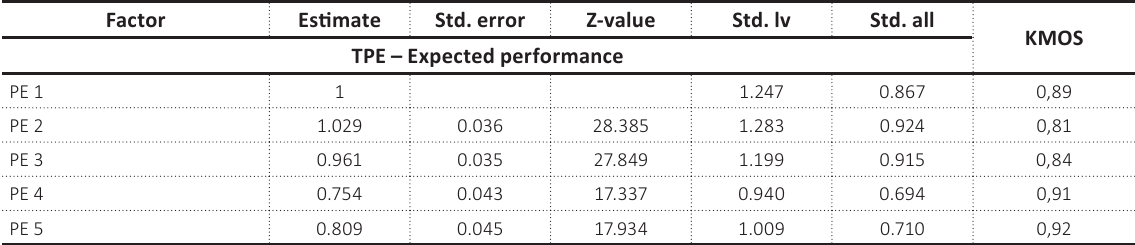
Table 5. SEM for the EE factor – Overview of results for latent variables